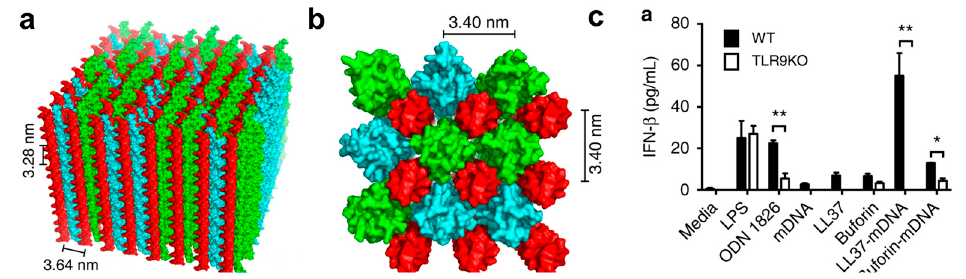
Figure 15. Nucleic acid helices complexed with ( a ) melittin and ( b ) LL-37. Peptide helices are shown in green (N to C polarity) or teal (C to N polarity), with dsDNA shown in red. ( c ) Induction of type 1 interferon production through TLR9-dependent mechanisms, highlighting the immunomodulatory capabilities of LL37-nucleic acid complexes. Image adapted from [213] under the Creative Commons